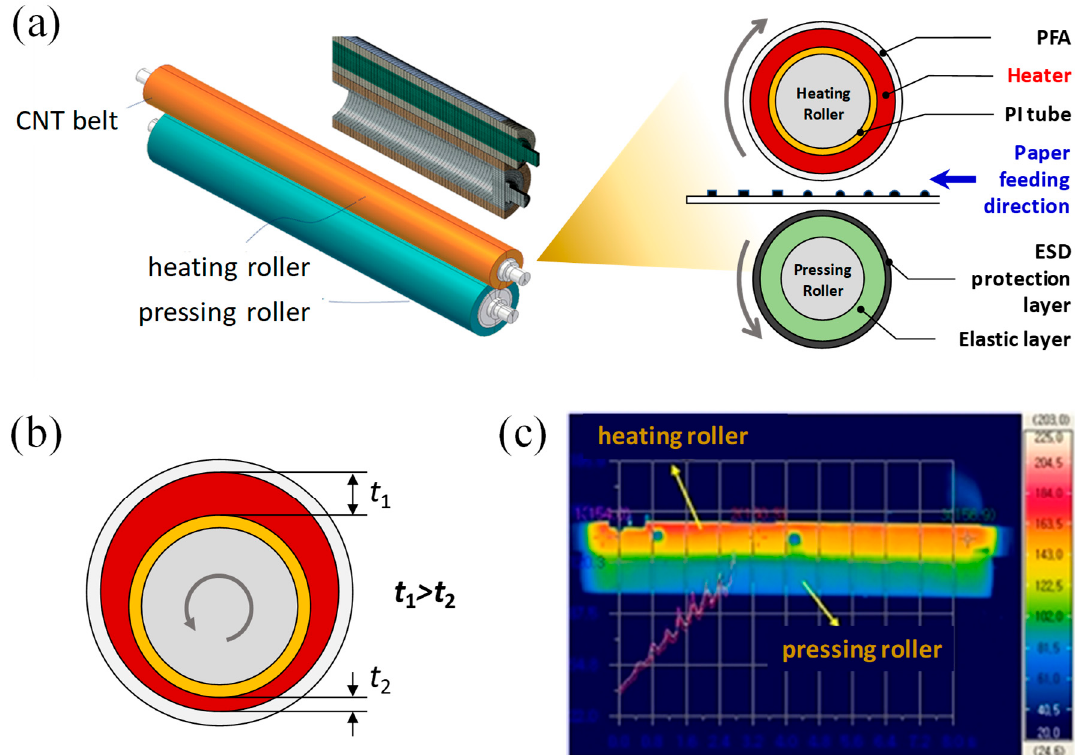
Figure 1. ( a ) Schematic of laser printer fusing element, ( b ) thickness discrepancy of multiwalled nanotube (MWNT)/rubber heater layer in circumferential direction caused by misalignment of the roller axis to extrusion axis, and ( c ) extruded heating roller showing temperature irregularity in the circumferential direction.